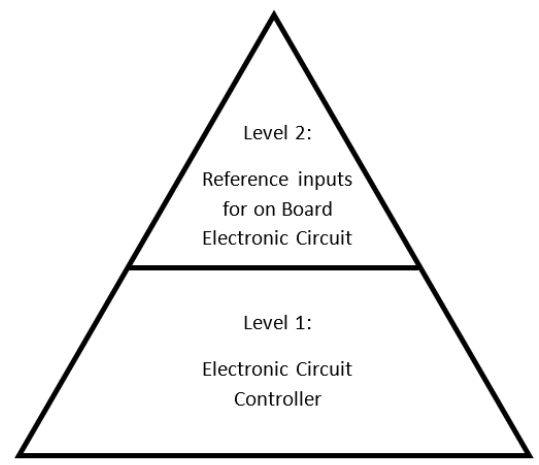
Figure 4. Hierarchical control structure.